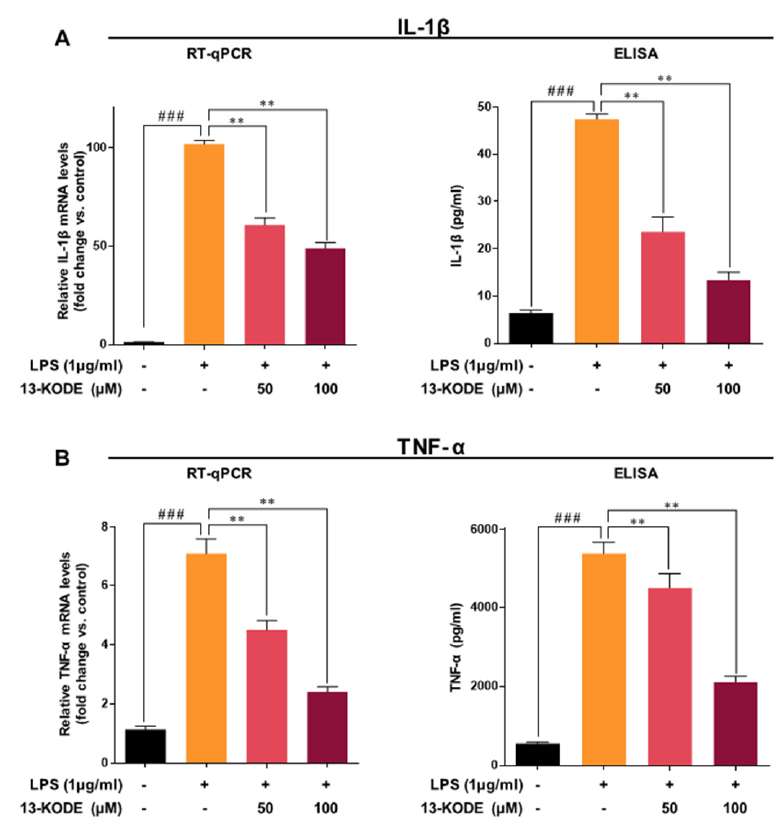
Figure 3. Inhibition of IL-1 β and TNF- α production by 13-KODE in LPS-stimulated RAW 267.4 cells. RAW 264.7 cells were incubated with 13-KODE (50 and 100 µM) prior to stimulation with 1 µg/mL LPS for 1 day and total RNA was isolated. The transcript levels of IL-1 β ( A ) and TNF- α ( B ) were measured by qRT-PCR. RAW 264.7 cells were incubated with 13-KODE (50 and 100 µM) prior to stimulation with 1 µg/mL LPS for 1 day and of IL-1 β ( A ) and TNF- α ( B ) amounts in the cultured supernatants were measured using commercial ELISA kits. The values correspond to the mean ± standard deviation, n = 3. ** p < 0.01; ### p < 0.001.